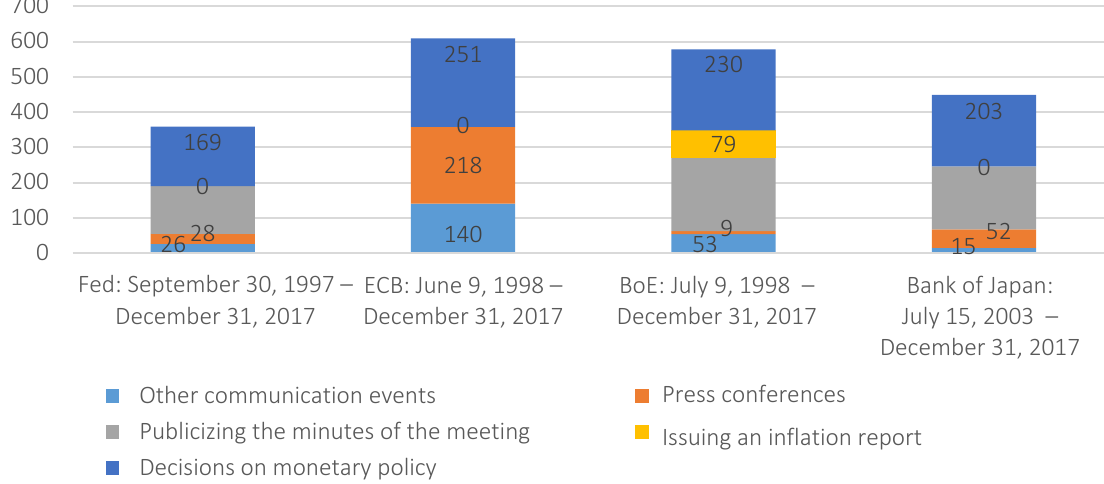
Figure 2. Communication channels of central banks of developed